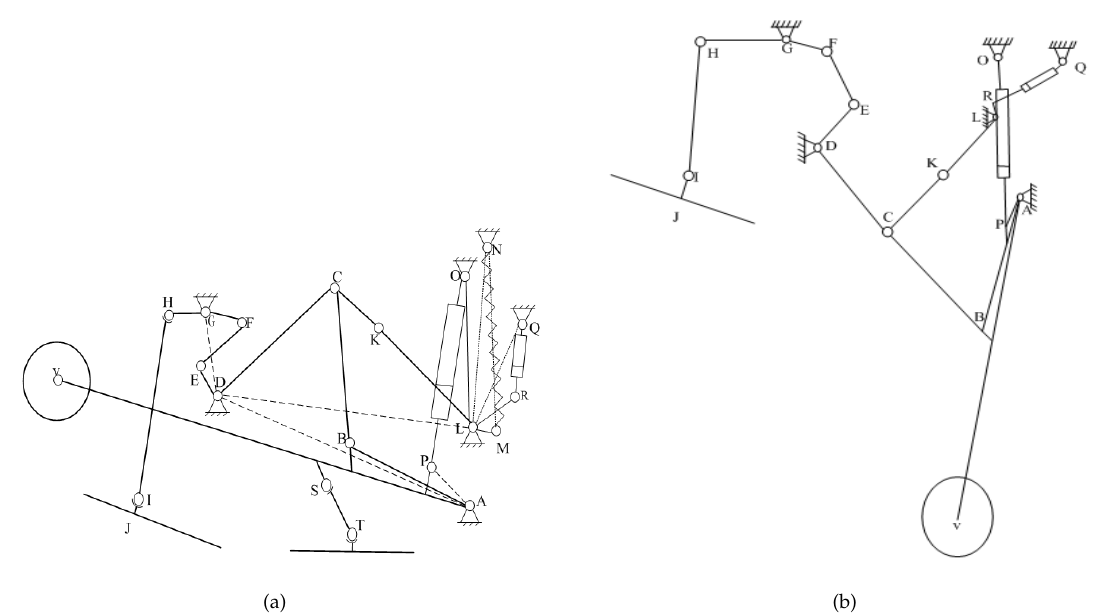
Figure 3. The landing gear retraction mechanism: ( a ) the retracted position; ( b ) the extended